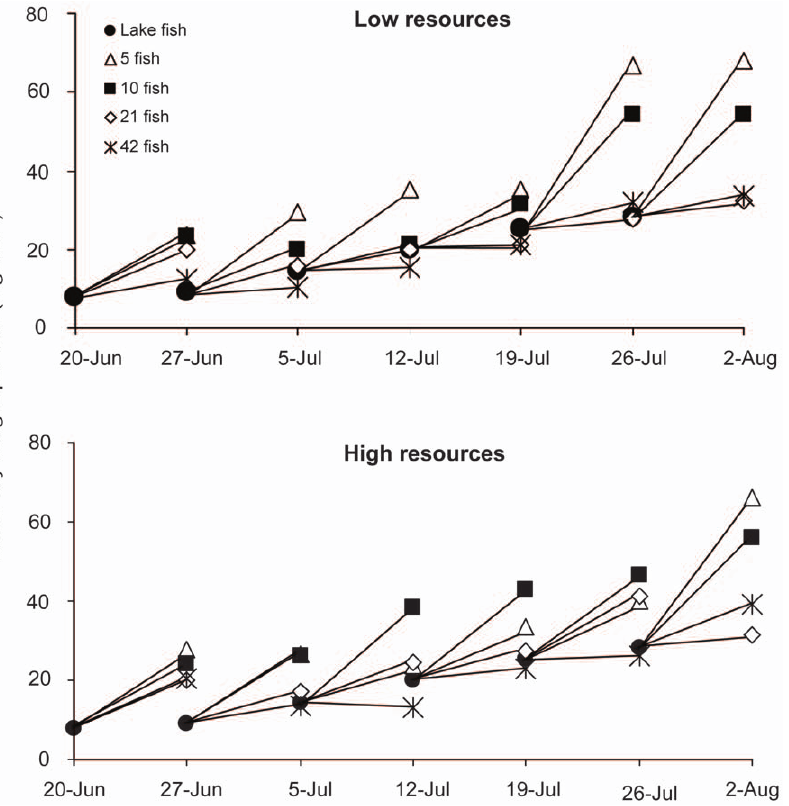
Figure 6. Mean dry weight per fish before and after one week in enclosures with low algal resource and high algal resource level related to fish abundance stocked in the enclosures at the different sampling dates.